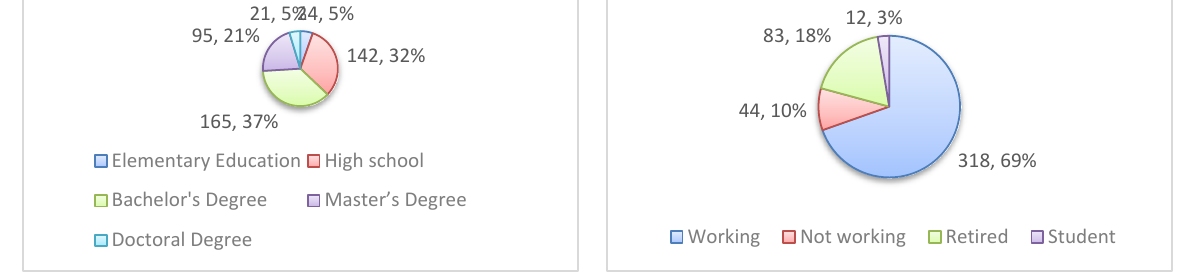
Fig. 2. The Demographic Characteristics of the